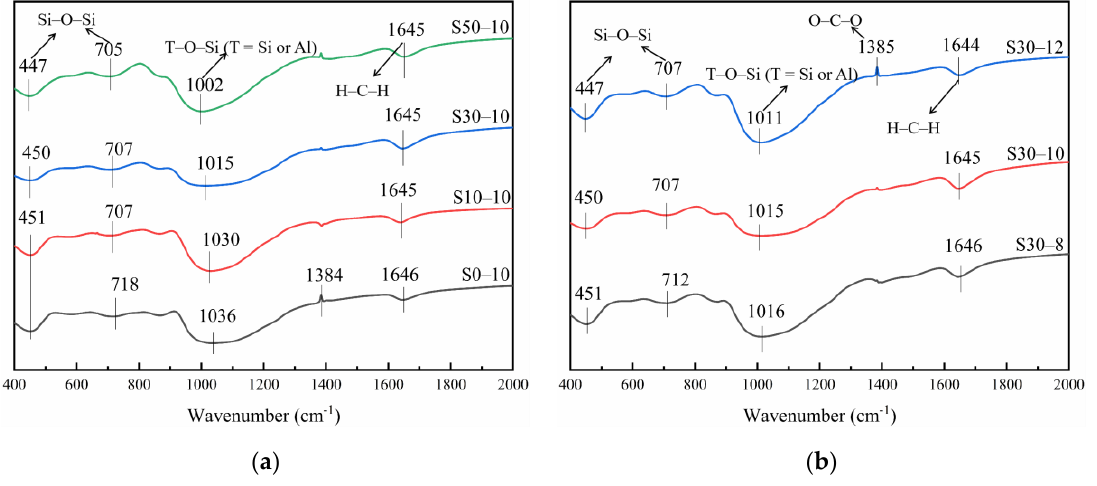
Figure 7. FT-IR spectra of the alkali-activated metakaolin-based geopolymer specimens according to the ( a ) slag and ( b ) Na 2 O content.